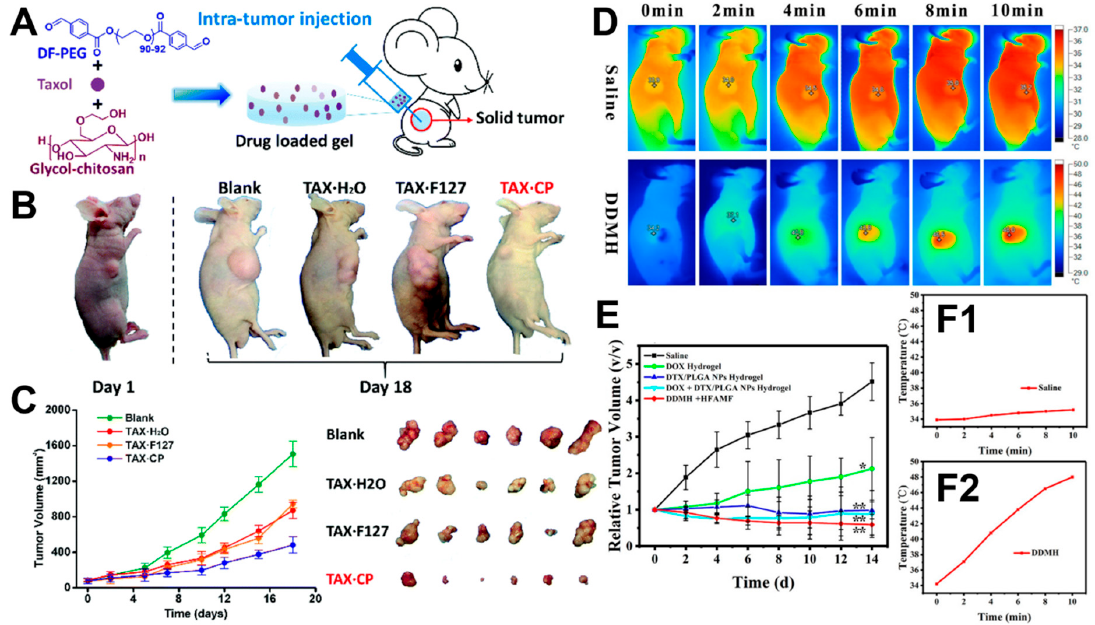
Figure 7. ( A ) Schematics of the intratumor experiment through hydrogel injection. ( B ) Results of the intratumor injection in nude mice divided into four groups according to di ff erent injection treatments, including only injected saline (Blank), only injected Taxol solution (Tax · H 2 O), injected Pluronic F127 hydrogel with Taxol (Tax · F127), and injected self-healing hydrogel based on glycol chitosan and DF-PEG with Taxol (Tax · CP) (the animal experiments were performed in accordance with protocols approved by the ethics committee of Cancer Hospital, Chinese Academy of Medical Science). ( C ) The volume and appearance of tumors in mice in the four groups. Reprinted with permission, as in Reference [81]. © 2017, Royal Society of Chemistry (London, UK). ( D ) Infrared thermal images for tumor-bearing mice under exposure to an AMF at di ff erent post-injection treatments (saline and DDMH) (the animal experiments were performed in accordance with protocols approved by the Laboratory Animal Research Center, Tsinghua University). ( E ) Tumor growth curves with di ff erent treatments (only saline, only DOX solution, DTX solution with PLGA nanoparticles, DOX solution with PLGA nanoparticles, and DDMH solution with AMF). ( F1 , F2 ) The temperature of di ff erent tumor sites shown during the exposure. Reprinted with permission [82]. © 2015, American Chemical Society (Washington, DC,